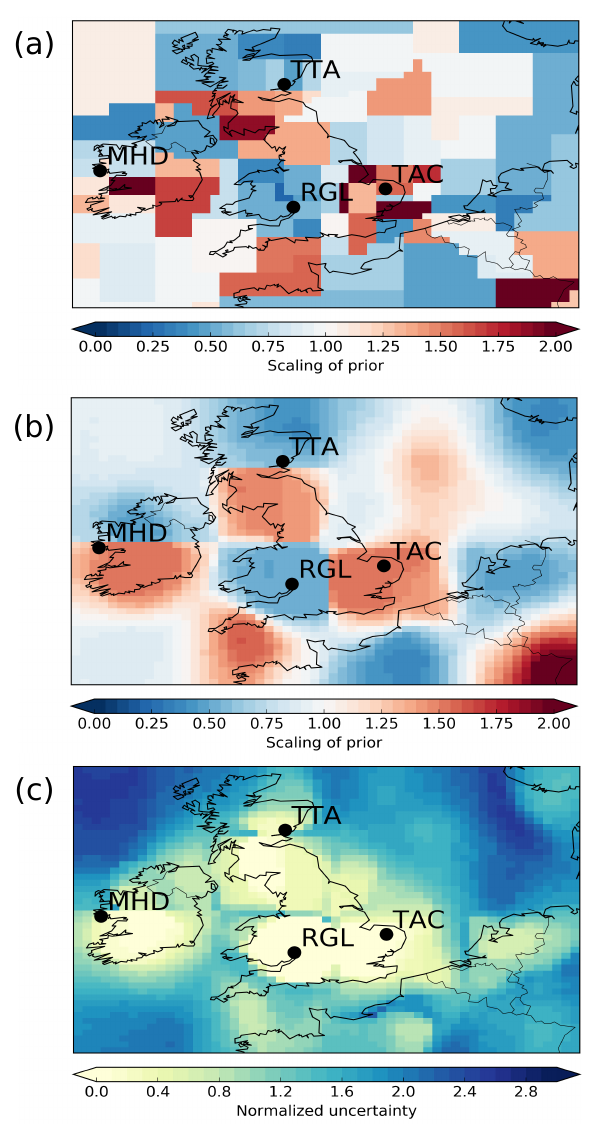
Figure 4. Maps of the posterior scaling of the prior for the sub- jectively optimized fixed grid (a) and the mean of the transdimen- sional inversion posterior (b) . The uncertainty of the transdimen- sional posterior is shown in (c) , defined as the normalized 5th–95th percentile range.